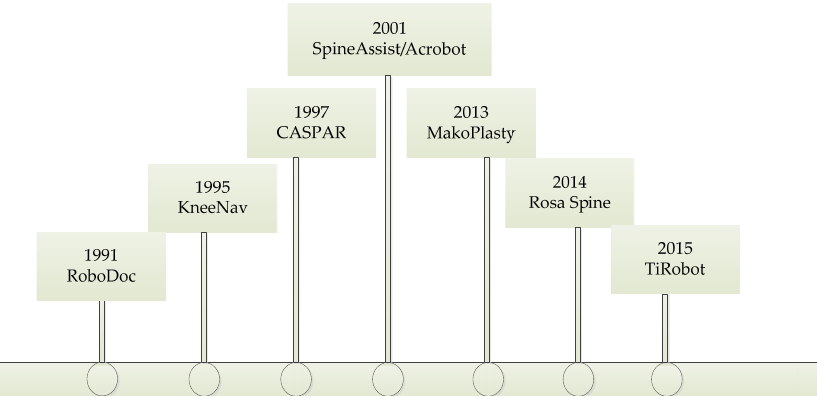
Figure 3. Timeline of typical orthopedic robots.